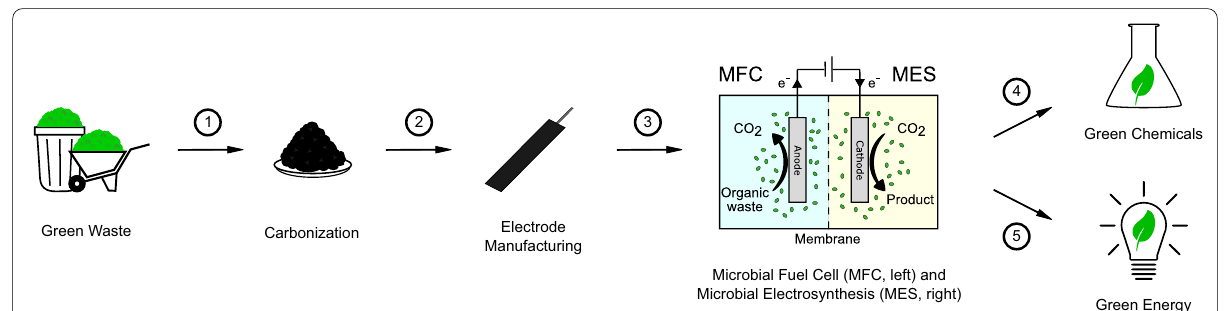
Fig. 5 Schematic presentation of electrode manufacturing from green waste and application in bioelectrochemical systems for the production of “green” chemicals or energy: green waste is carbonized and activated through hydrothermal carbonization and/or pyrolysis (1), formed into suitable electrodes (2) and used in electro-biotechnological applications (3) to produce green chemicals in bioelectrosynthesis (4) or green energy in microbial fuel cells